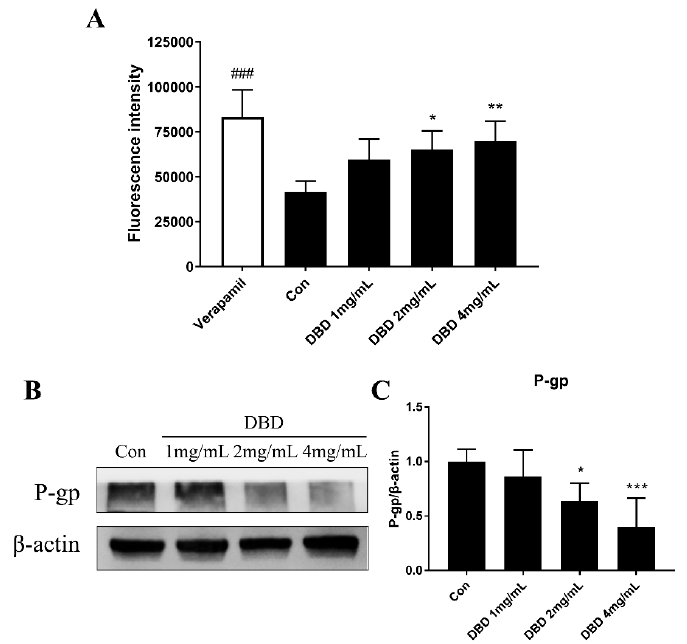
Figure 6. Effect of DBD on P-gp efflux activity and protein expression in A549 Cells. ( A ) The intracellular mean fluorescence intensity associated with Rh 123 was determined by flow cytometry. Verapamil (50 μ M) was used as a positive control. ( B and C ) The protein expression of P-gp in A549 cells. Data were expressed as mean ± SD of five independent experiments. * p < 0.05, DBD 2mg/mL versus Con. ** p < 0.01, DBD 4mg/mL versus Con. *** p < 0.001, DBD 4mg/mL versus Con. ### p < 0.001, Verapamil versus Con.